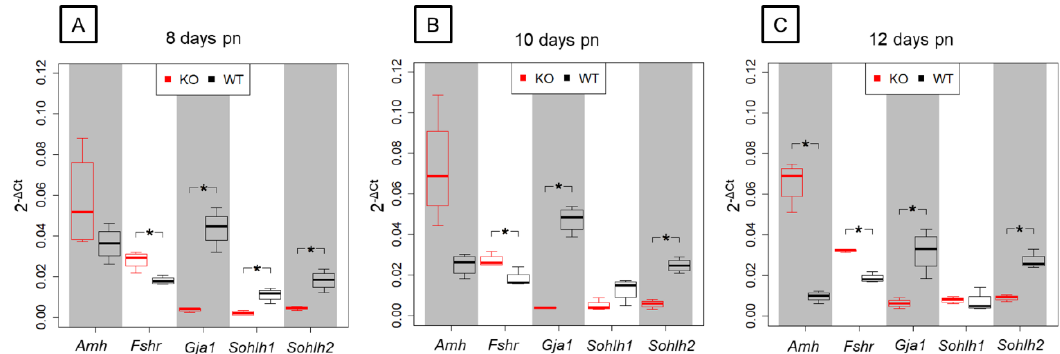
Figure 8. Relative gene expression in prepubertal SCCx43KO mice and their WT littermates. Box plots showing 2 - Δ Ct -values of relative gene expression in KO and WT littermates for the candidate genes Amh , Fshr , Gja1 , Sohlh1 and Sohlh2 between KO and WT littermates in three age groups ( n = 4 per genotype and age group, p (FWER) < 0.05). ( A ) In 8-day-old SCCx43KO, Fshr , Gja1 , Sohlh1 and Sohlh2 are significantly, differentially expressed. ( B ) Fshr , Gja1 and Sohlh2 are significantly, differentially regulated in 10-day-old SCCx43KO mice. ( C ) A significant, differential gene expression is detectable for Amh , Fshr , Gja1 and Sohlh2 in 12-day-old SCCx43KO mice. qRT-PCR data correlate with NGS data. RNA expression level is normalized to the expression level of the housekeeping gene β -Actin . KO: knockout, NGS: next-generation sequencing, pn: post-natum, qRT-PCR: quantitative real-time reverse transcription-PCR, SCCx43KO: Sertoli cell-specific Cx43 knockout, WT: wild type.